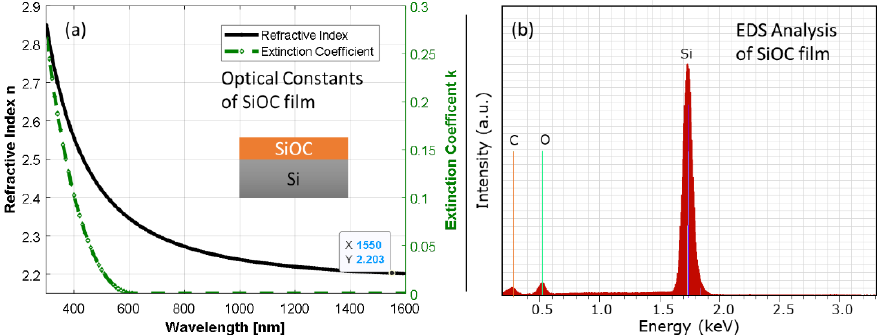
Figure 2. ( a ) Measured optical constants (n and k) spectra and ( b ) EDS analysis of SiOC thin film.